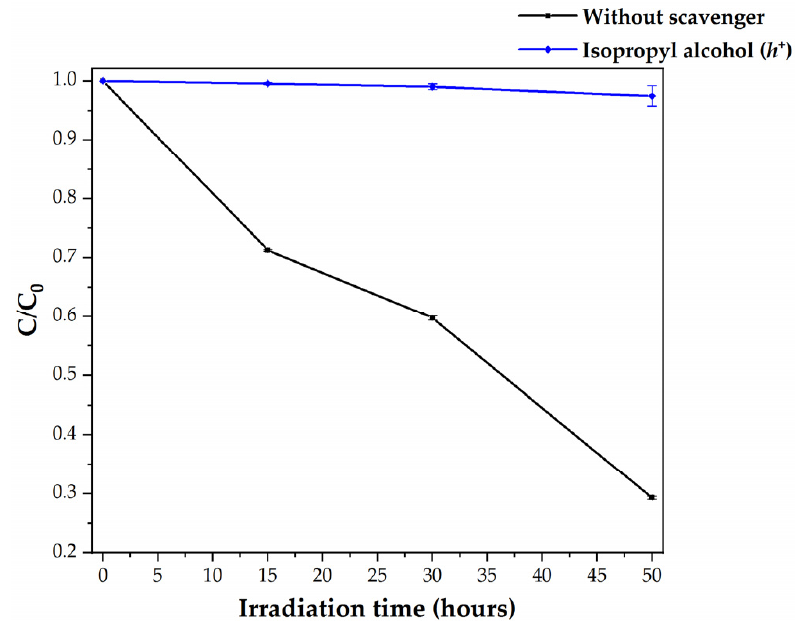
Figure 5. Visible-light photocatalytic degradation of HDPE MPs by C,N-TiO 2 in the absence and presence of IPA as h + and OH ● scavenger.